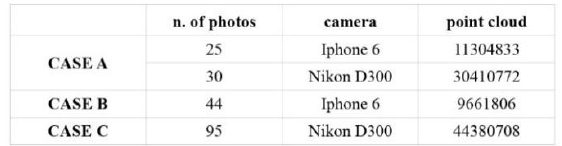
Table 1. Number of photos, model of camera, and point cloud.